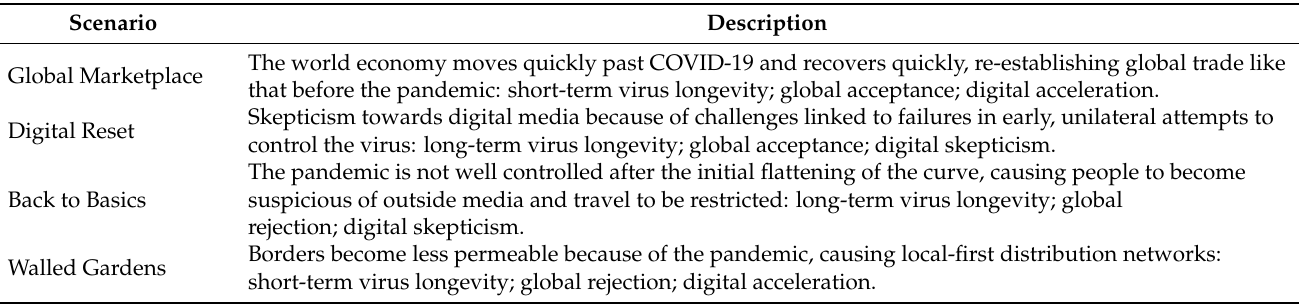
Table 2. Four possible futures investigated in the foresight Delphi (adopted by the authors according to [43]). Scenario Description Global Marketplace Digital Reset Back to Basics Walled